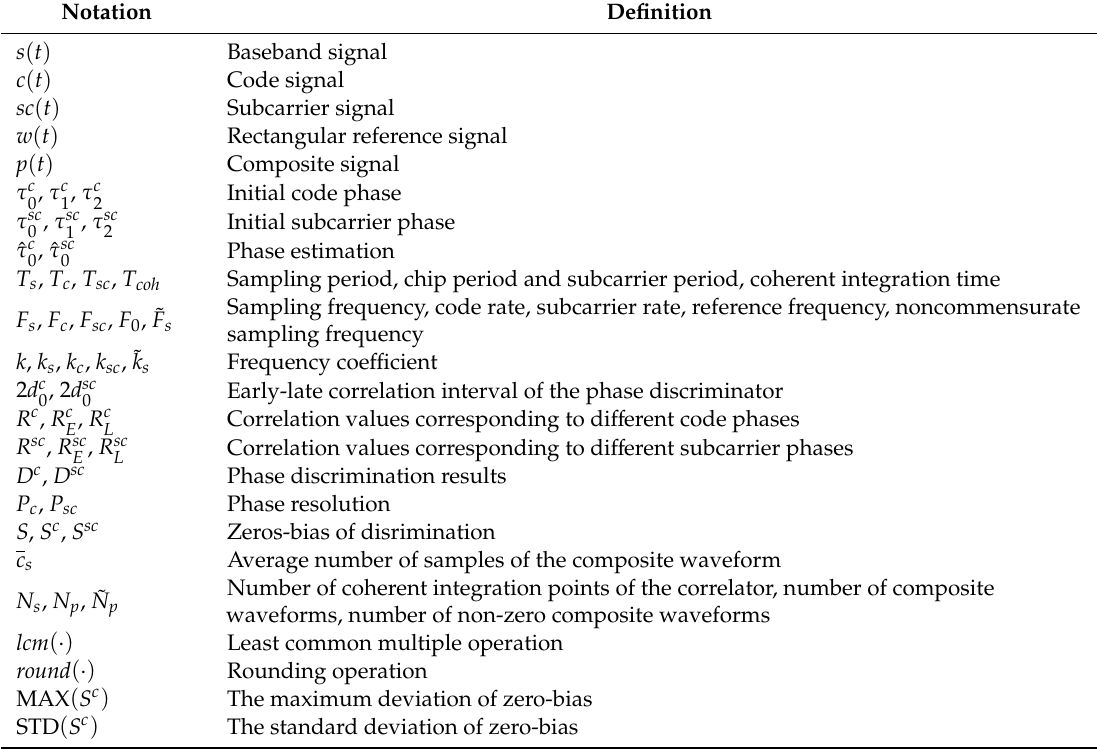
Table 1. Frequently used